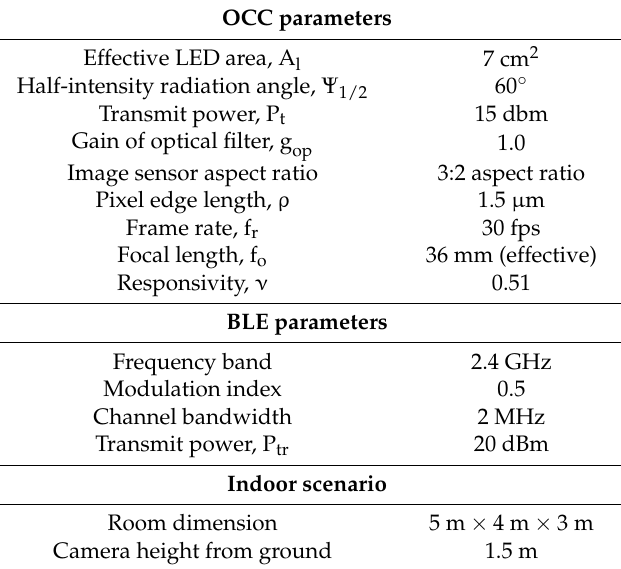
Table 3. Unchanged system parameters for the